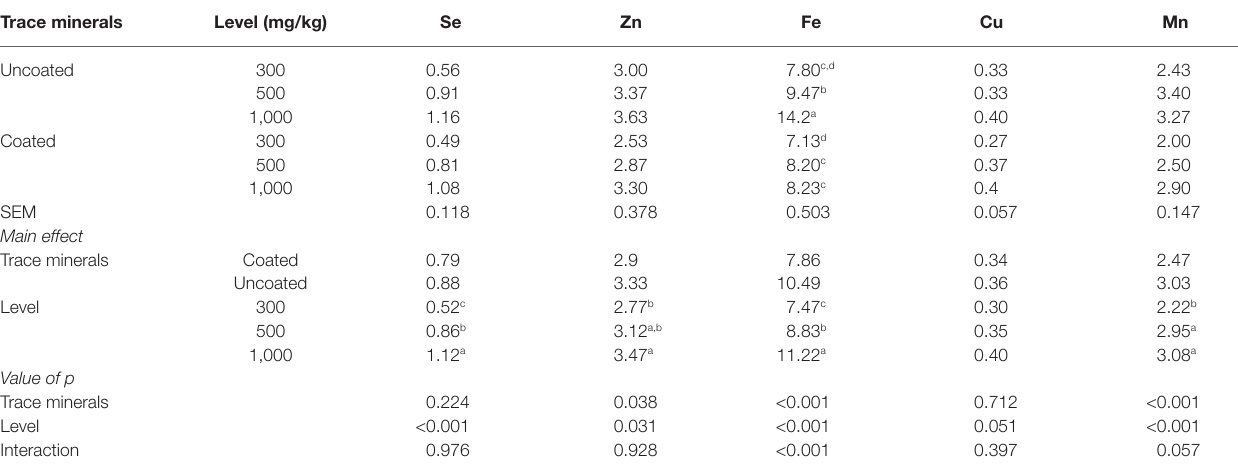
TABLE 6 | Effects of trace mineral type (coated or uncoated) and supplementation level (300, 500, or 1,000 mg/kg) of trace minerals on fecal excretion ion metals contents in ducks (mg/kg). Trace